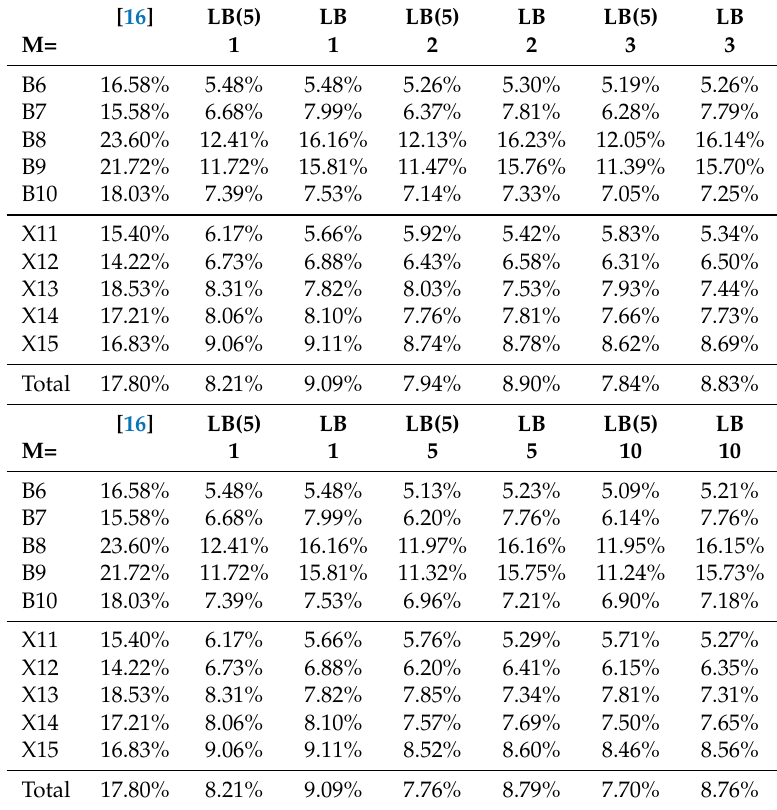
Table 11. Dual bounds for datasets B and X, computing of dual bounds LB(5) and LB with LP+cuts computations, aggregation of production time steps and scenario decomposition varying M the maximal number of scenarios in each